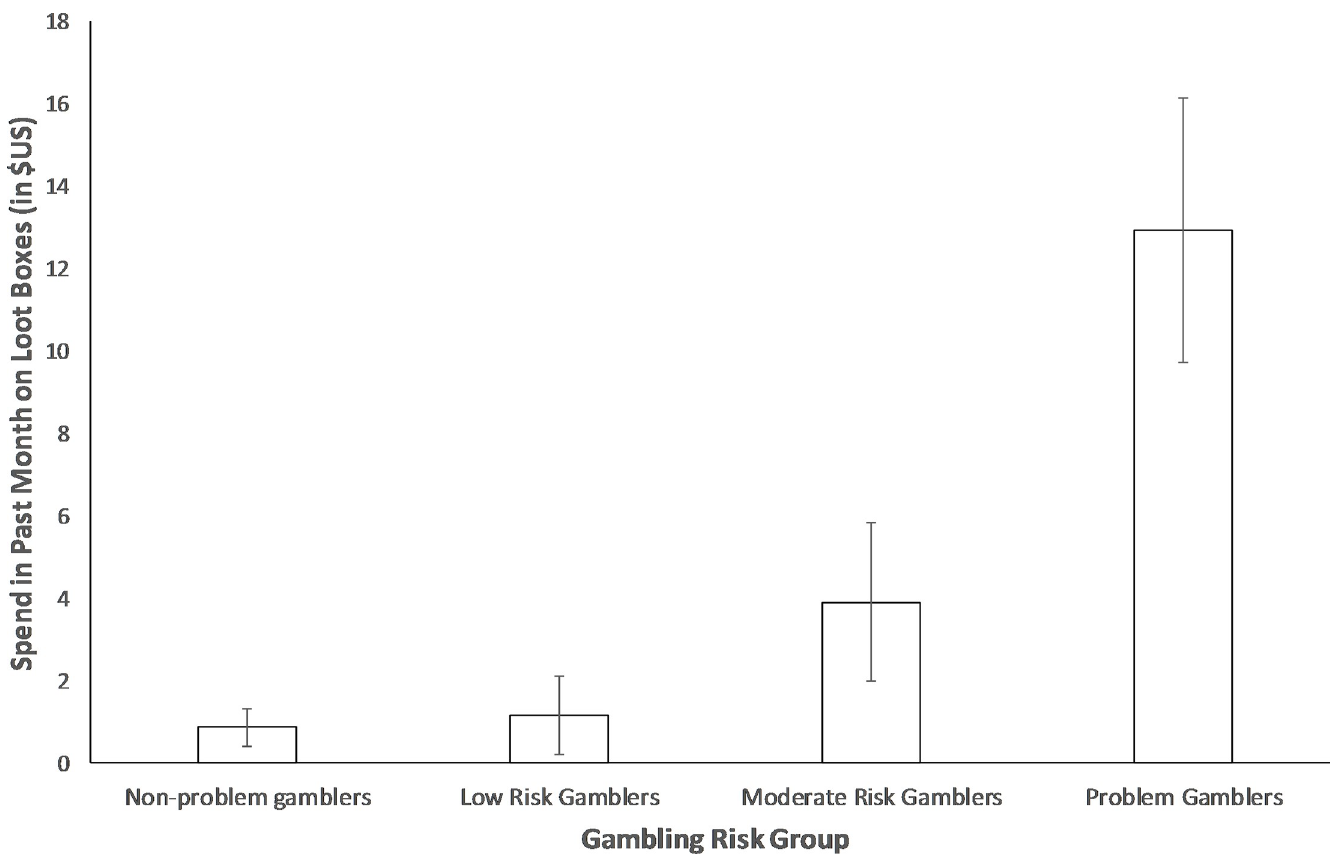
Fig 1. Differences in loot box spending between participants classified by the original classification scheme of the PGSI to be non-problem gamblers, low risk gamblers, moderate risk gamblers, and problem gamblers. Error bars represent 95% Confidence